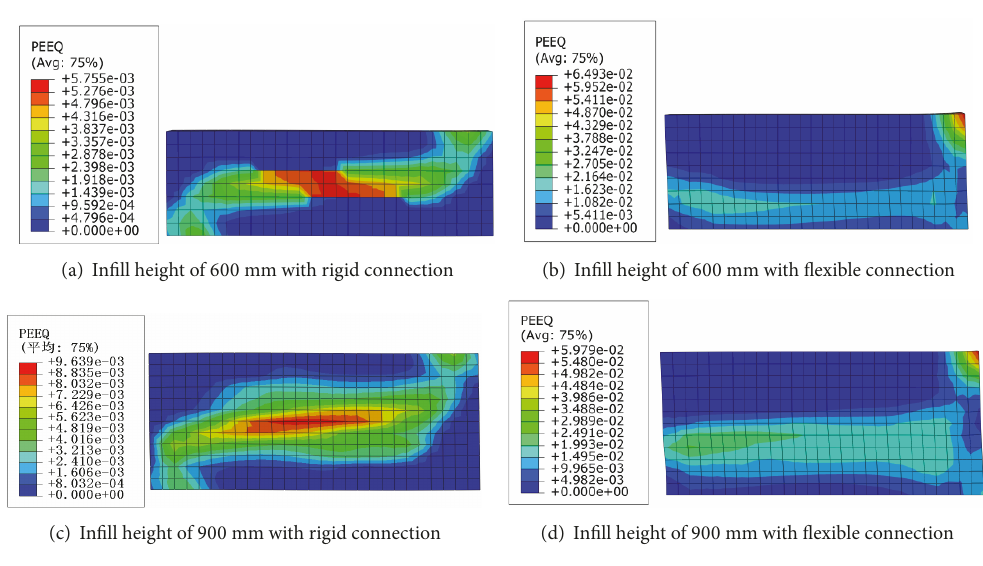
Figure 26: Plastic strain in infill wall with different connection modes.